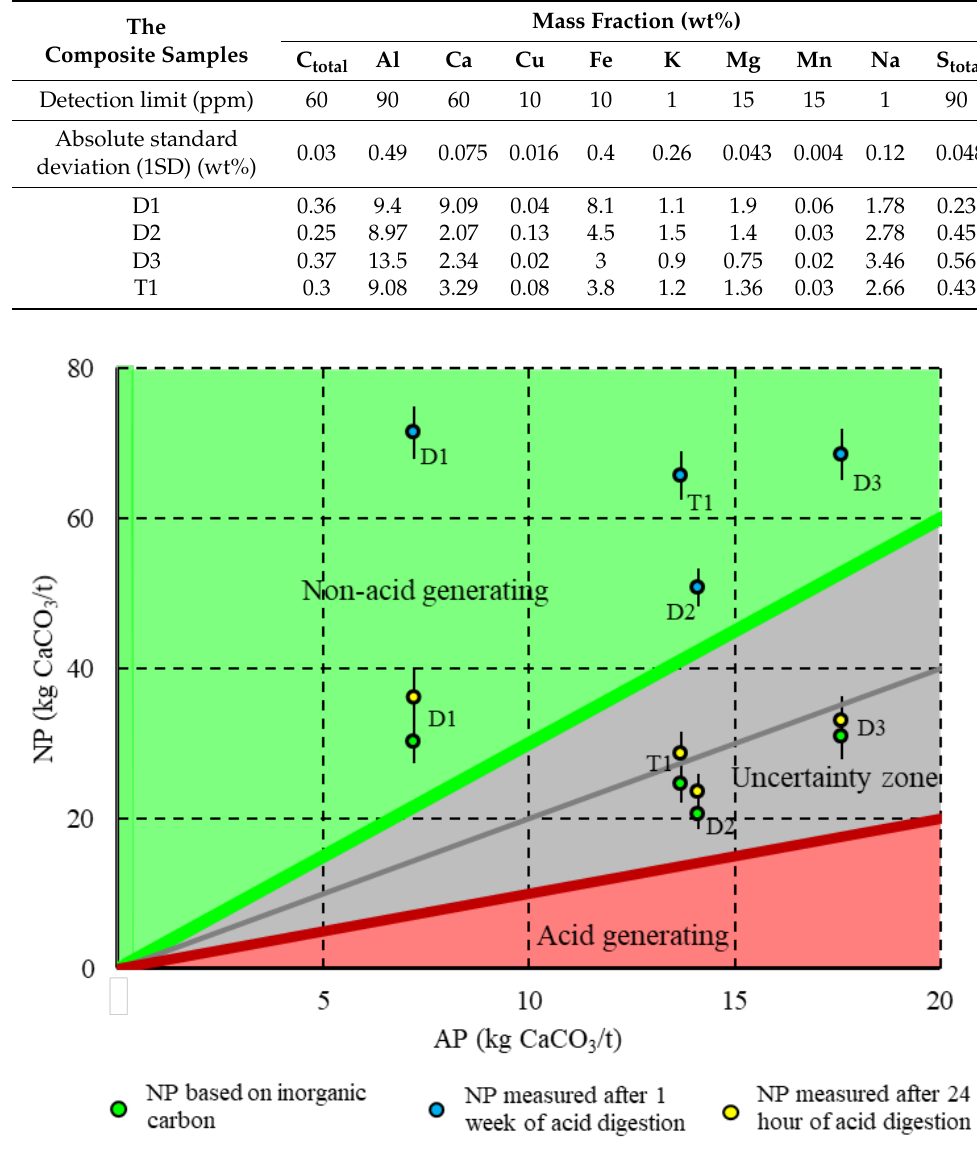
Figure 3. Acid–base accounting classification based on the neutralization potential ratio. Table 2 . Physical properties of composite samples.